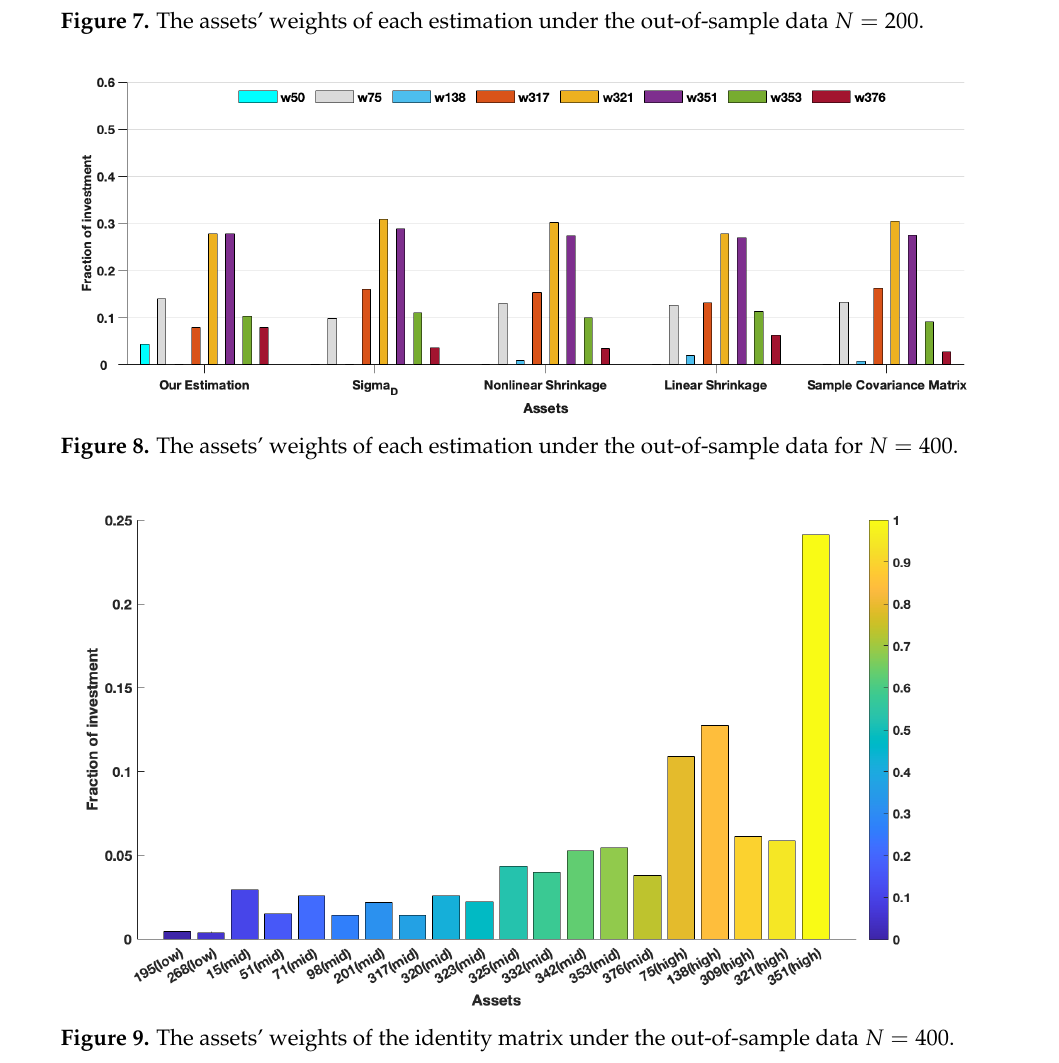
Figure 9. The assets’ weights of the identity matrix under the out-of-sample data N =